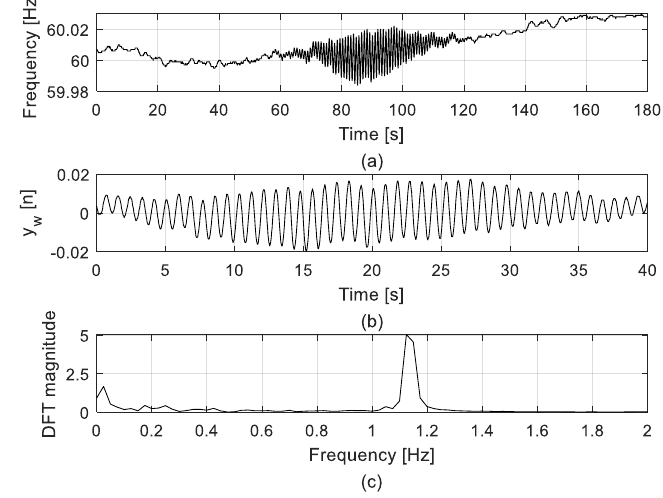
Figure 10. Modal oscillations in the system frequency of the New England power system: ( a ) PMU data; ( b ) oscillation data for modal identification; ( c ) DFT magnitude of the oscillation data.